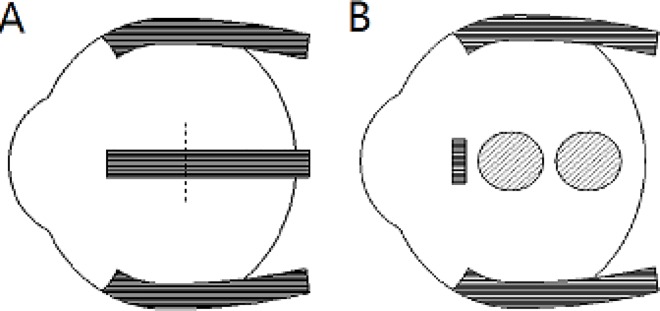
External view of muscle reflection (A). The lateral rectus was cut off in the position of the imaginary line. External view of the spot distribution of the two irradiation zonesper quadrantin each guinea pig (B).